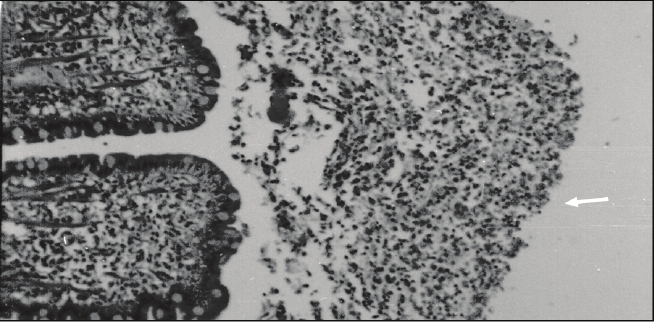
FIgURE 3 - Picture of the mucosa after 30-minute ischemia and 2-hour reperfusion. Arrow shows the large amount of debris on the mucosa surface (H&E staining, original magnification: